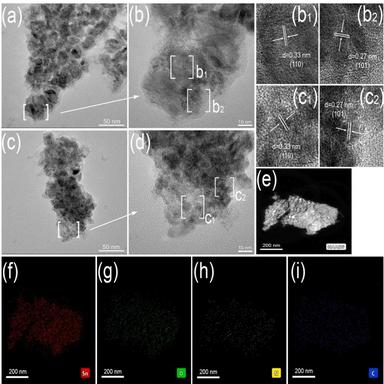
TEM (a, c) and HRTEM (b, d) images of SnO2 @PPy-1 and SnO2 @PPy-2; HAADF-STEM image of (e) SnO2 @PPy-2, and (f-i) elemental mapping images of Sn, O, N, and C in SnO2 @PPy-2.